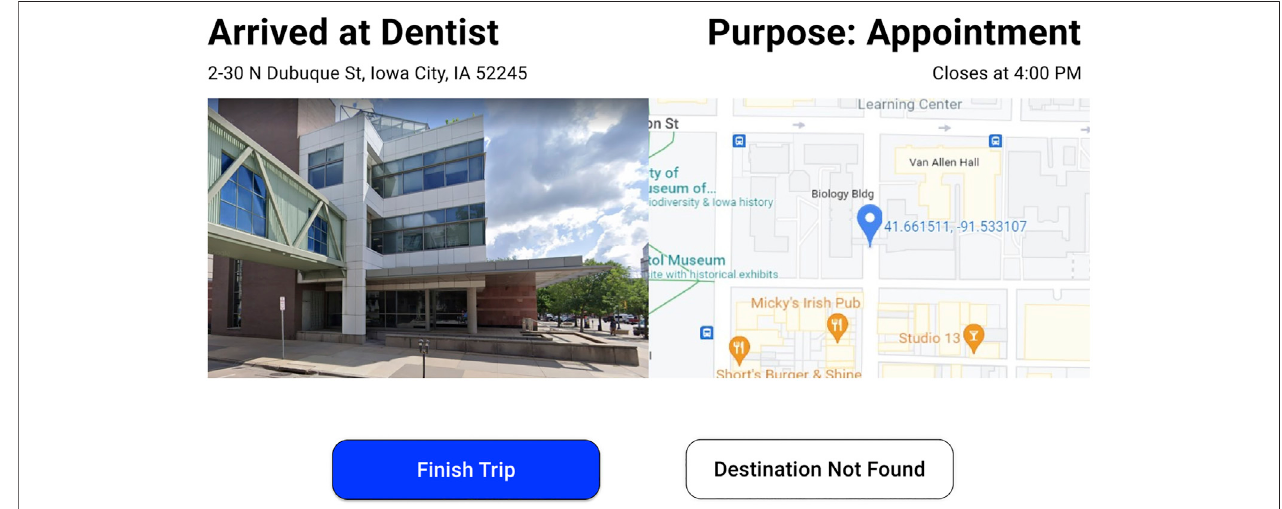
FIGURE 8 | Prototype of the arrival orientation reminder.